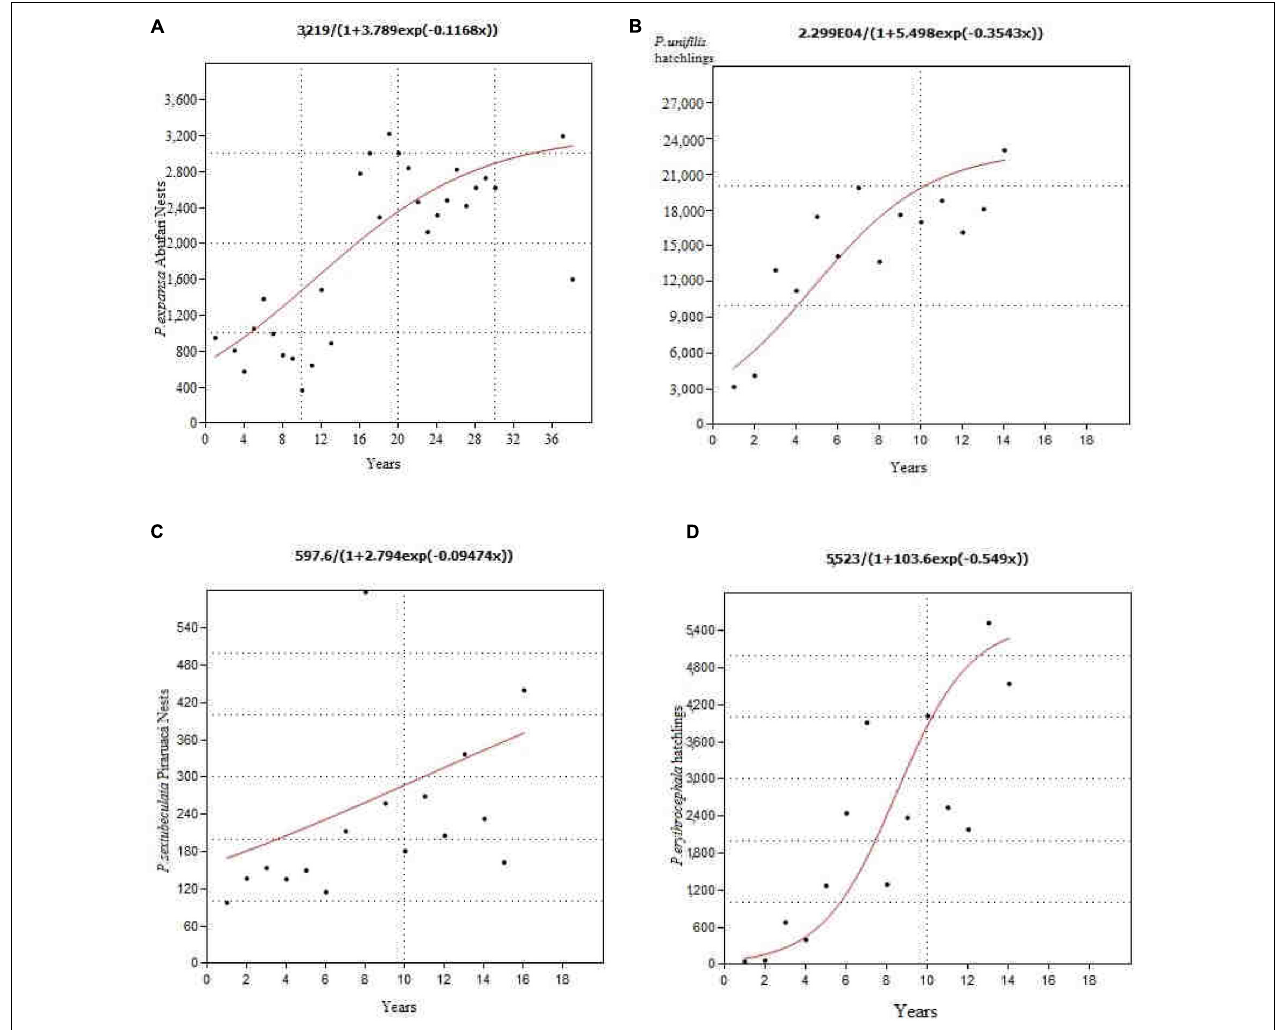
FIGURE 10 | Logistic growth curves of the number of nests and hatchlings (A) nests of P. expansa , Abufari, Purus River; (B) hatchlings of P. unifilis , Andirá River; (C) nests of P. sextuberculata , Piraruacá Lake, middle Amazon; (D) hatchlings of P. erythrocephala , Andirá River.